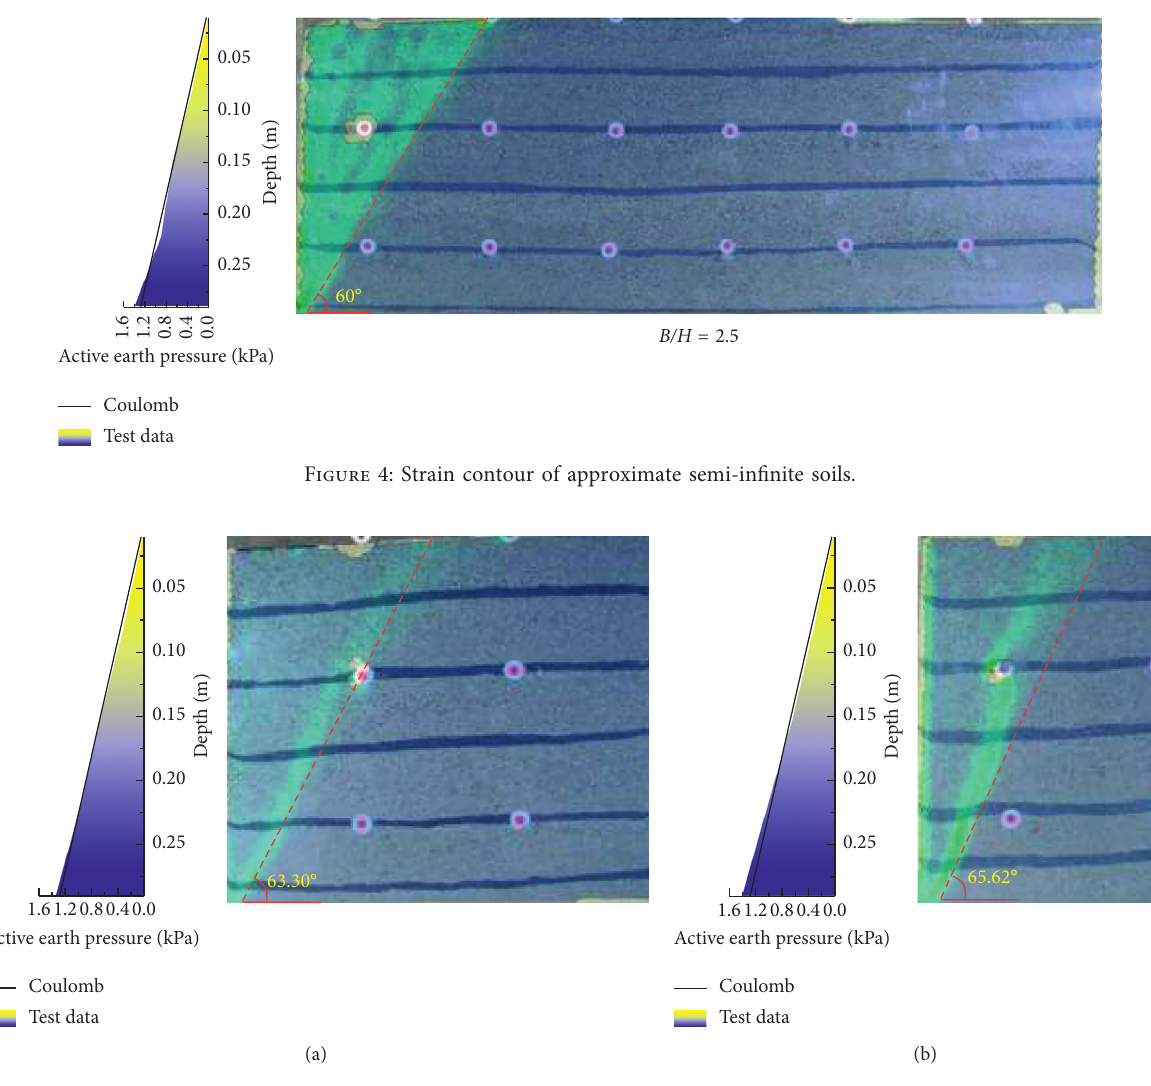
Figure 5: Strain contour of the narrow backfill: (a) B / H � 1; (b) B / H � 0 .